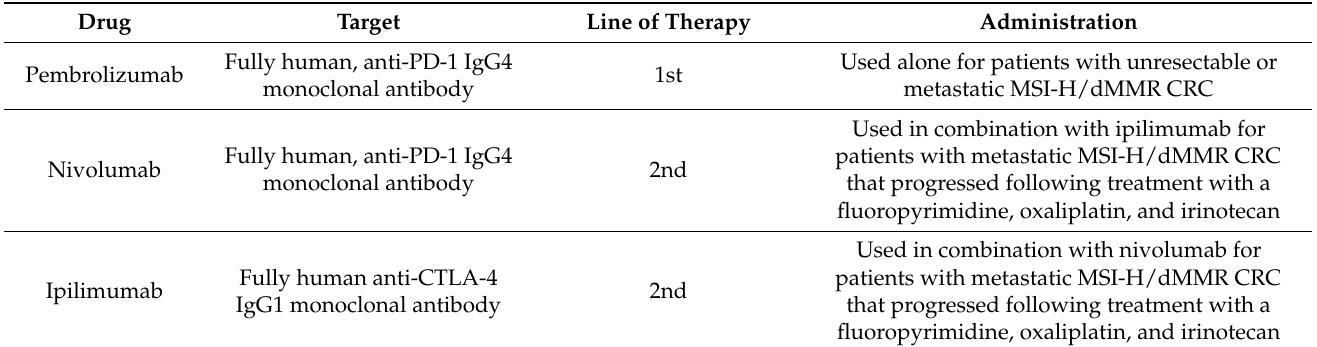
Table 2. FDA-approved checkpoint molecules in